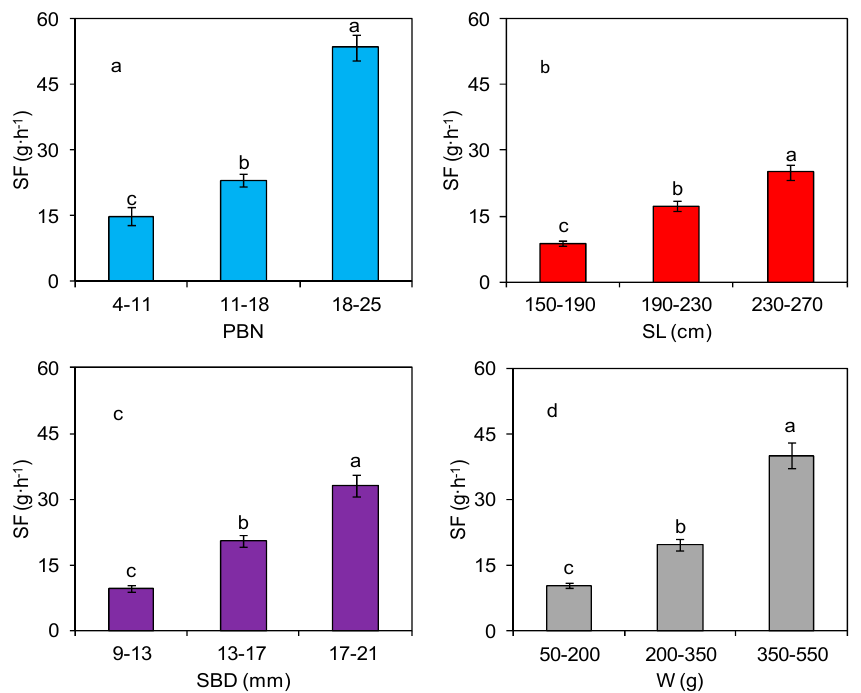
Figure 6. Comparison of the average stem-scale sap flow (SF) for different categories of ( a ) primary branch numbers (PBN), ( b ) stem length (SL), ( c ) stem base diameter (SBD), and ( d ) estimated stem biomass (W). The different lower-case letters in the figure indicate significant differences at p < 0.05 using the least significant difference (LSD) method.